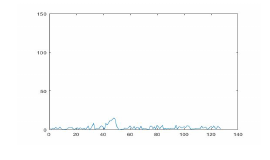
Figure 13: Approach in [17]